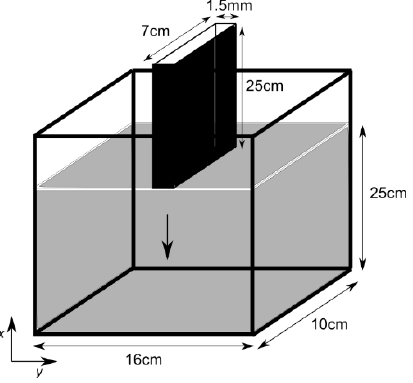
Figure 1. Sketch of the plate being immersed into the Carbopol fluid.